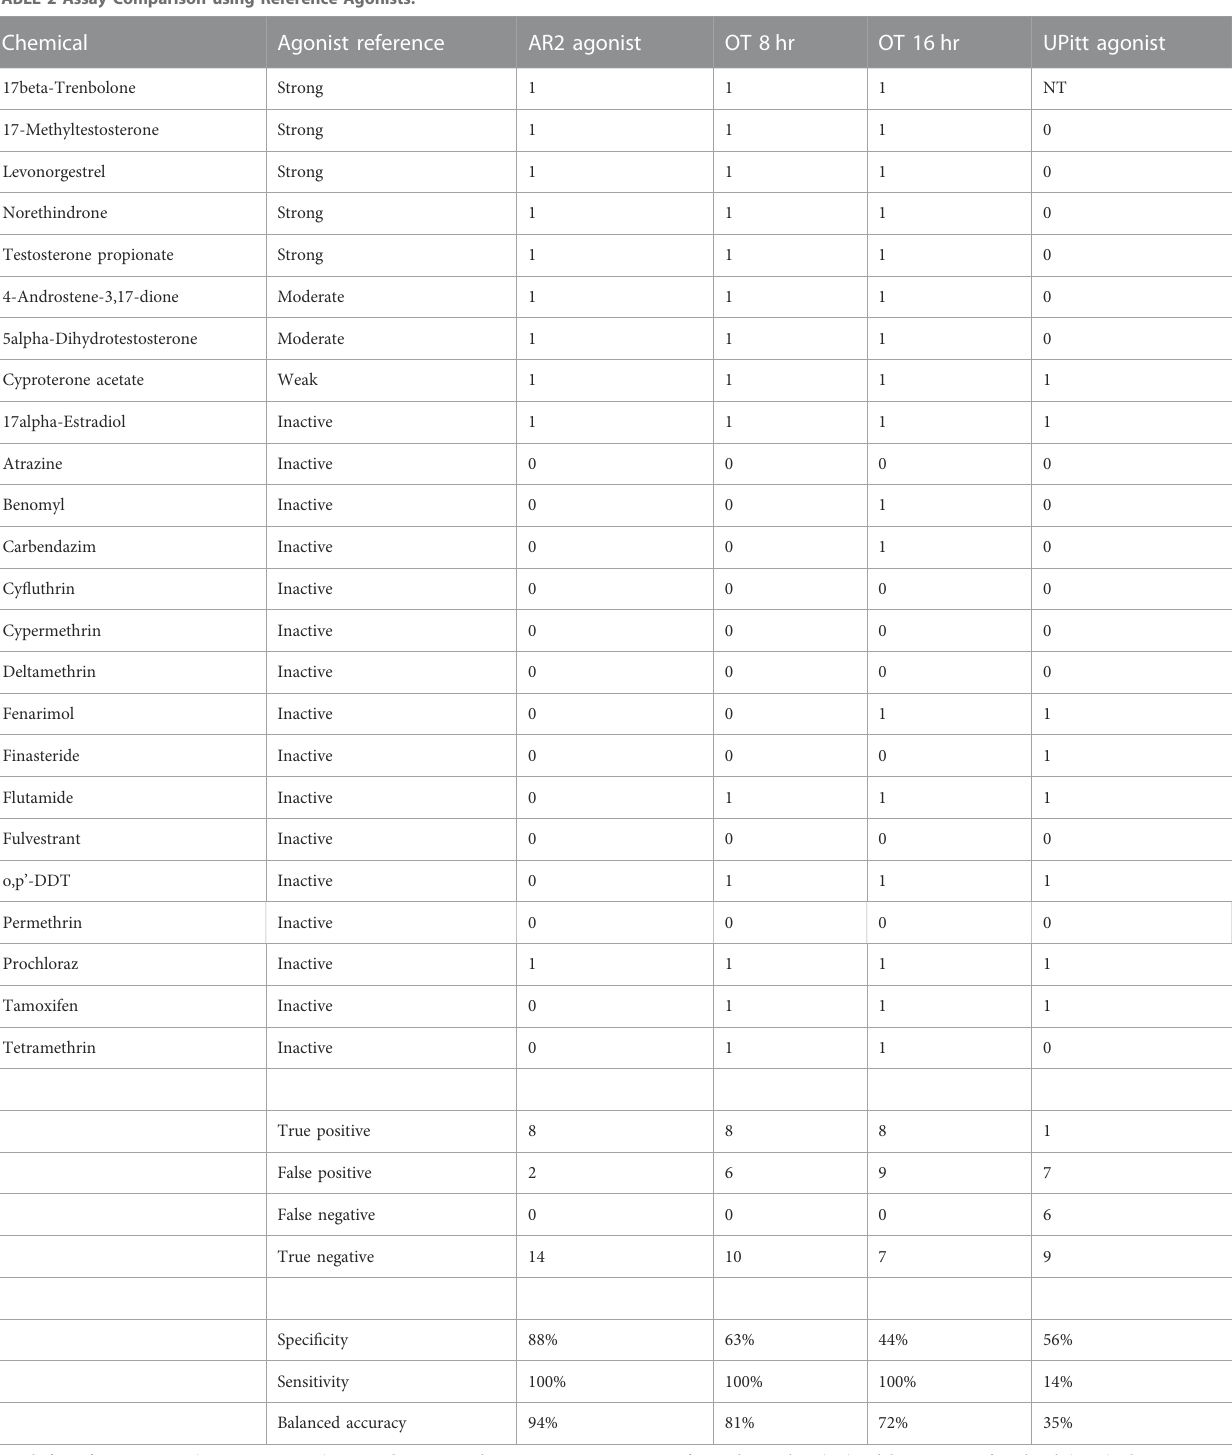
TABLE 2 Assay Comparison using Reference